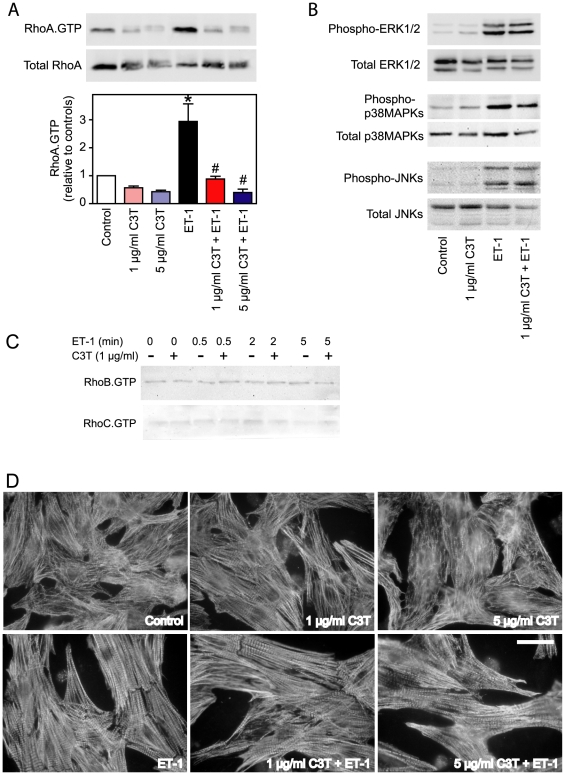
Inhibition of RhoA activation by C3T.Cardiomyocytes were unstimulated (Control) or exposed to 100 nM ET-1, 1 or 5 µg/ml C3T (2 h pretreatment) or ET-1 in the presence of C3T. Incubation times with ET-1 were 30 s (for activation of RhoA), 5 min (for activation of ERK1/2 or p38-MAPK), 15 min (for activation of JNKs) or 1 h (for effects on morphology). A, Affinity purified RhoA.GTP (upper panel) and total RhoA (center panel) were assessed by Western blotting. Blots are representative of 4 independent experiments. Densitometric analysis is provided in the lower panels. Results are means ± SEM (n = 4). * p<0.001 relative to controls, # p<0.001 relative to ET-1 alone (one way ANOVA with Newman-Keuls post-test). B, Phosphorylated or total ERK1/2 (upper blots), p38-MAPKs (center blots) or JNKs (lower blots) were assessed by Western blotting. The experiment was repeated with similar results. C, Cardiomyocytes were exposed to ET-1 for the times indicated with or without pretreatment with C3T. Affinity purified RhoB.GTP (upper image) and RhoC.GTP (lower image) were assessed by Western blotting. The experiment was repeated with similar results. D, Cardiomyocytes were immunostained with antibodies to troponin T. The experiment was repeated with similar results. Bar = 10 µm.